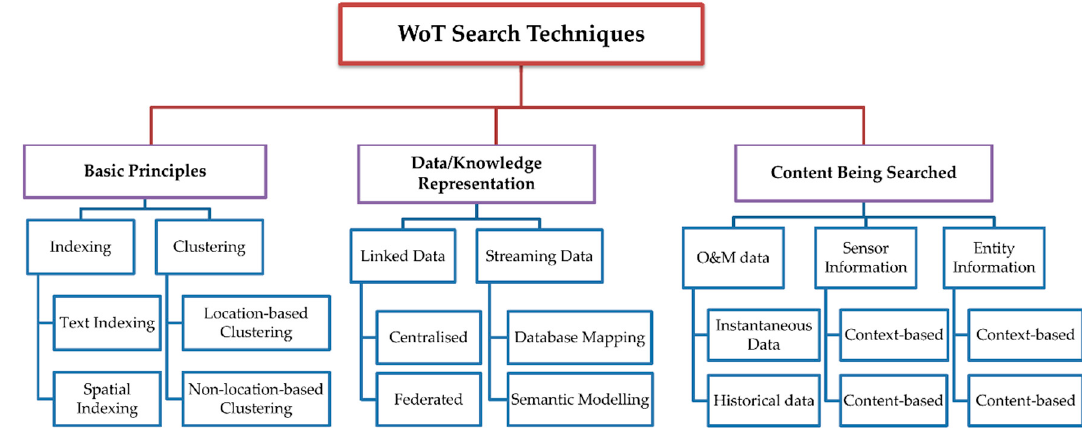
Figure 1. Classifications of the Search Techniques in WoT.